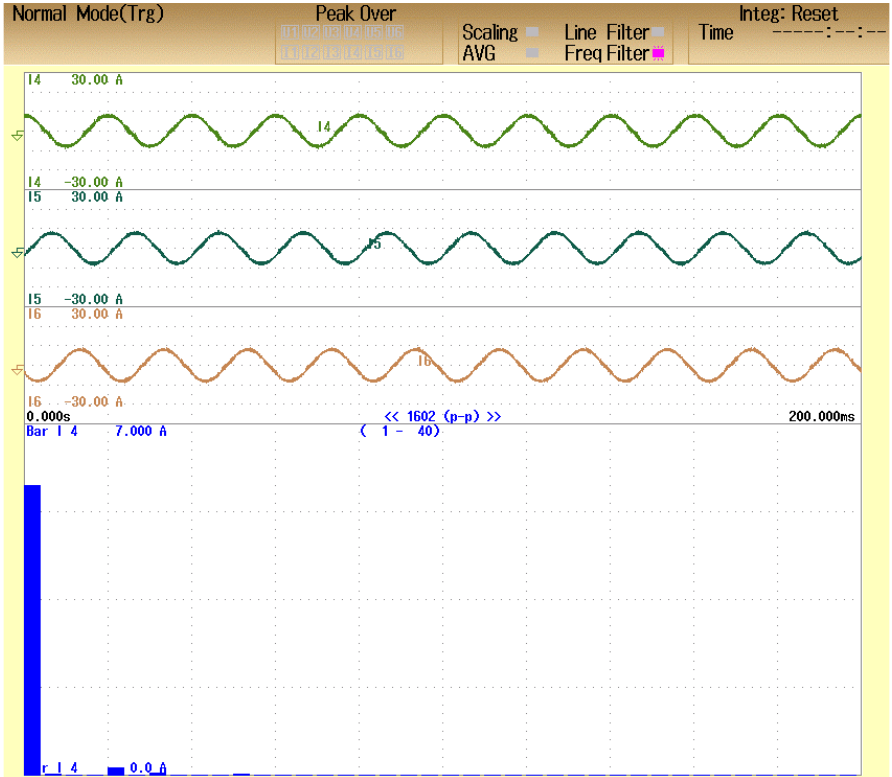
Figure 12. Load currents of three phases.